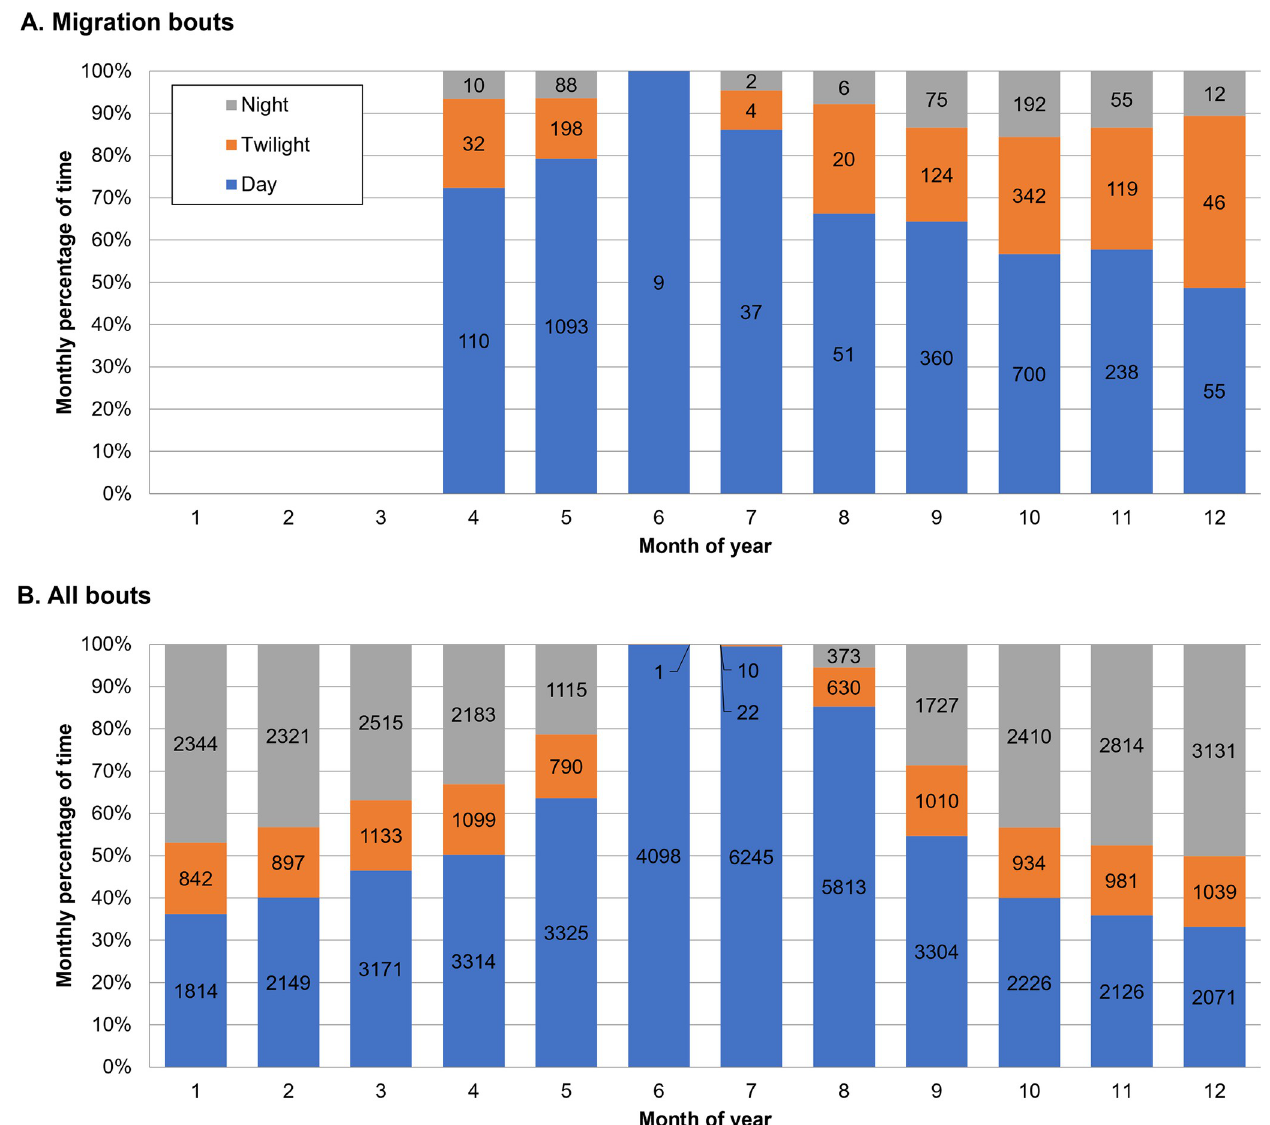
Fig 7. Diel patterns of 15 Vega gulls monitored in 2h bouts. Proportion of bouts is given for daylight (blue), twilight (ochre) and night (grey). Panel (A) presents the pattern for migration bouts only and must be compared with panel (B; all bouts) to infer which periods of the day are preferred for migration. The total number of recorded bouts is given in the